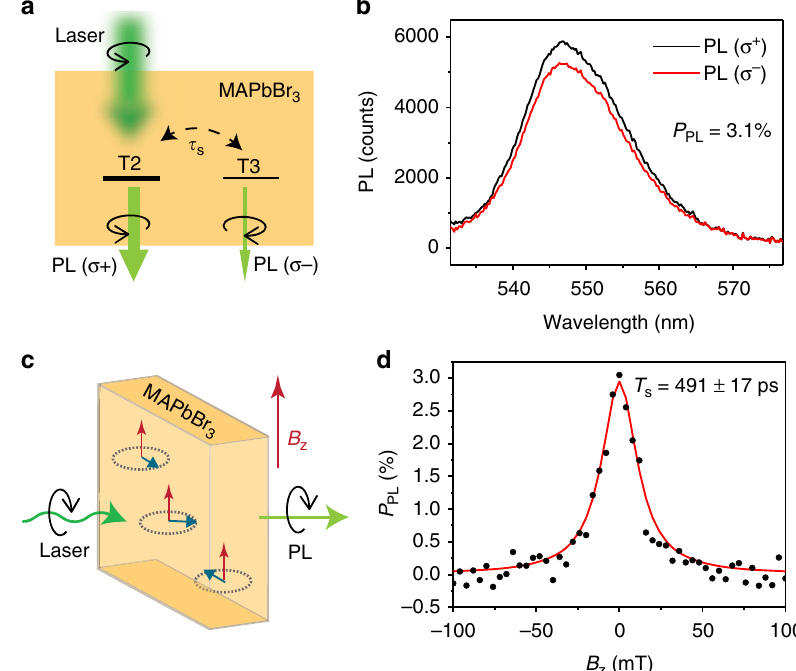
Fig. 1 Circular polarization of the PL and optical Hanle effect in MAPbBr 3 . a Schematic of the circularly polarized excitation ( σ + ) and polarized PL emission components, PL( σ + ) and P( σ − ) in MAPbBr 3 . T2 and T3 are two exciton states that can emit circularly polarized PL and have spin-dependent optical transitions near the MAPbBr 3 optical gap. Here PL( σ + ) > PL( σ − ), as marked by a heavier bar underneath the T2 label. Spin relaxation process couples the two exciton states with spin lifetime, τ s . b PL( σ + ) and PL( σ − ) emission spectra in MAPbBr 3 at steady state measured at 10 K. The degree of circular polarization, P PL = [PL( σ + ) − PL( σ − )]/[PL( σ + ) + PL( σ − )] of 3.1% is obtained. c Schematic set-up for measuring the optical Hanle effect. A magnetic fi eld, B z perpendicular to the PL light propagation direction is applied, which causes spin precession that leads to diminishing circular polarization of PL. d The P B fi t using Eq. (1), from which we obtained an effective exciton spin lifetime, T PL ( z ) response measured at 10 K. The red solid line is a